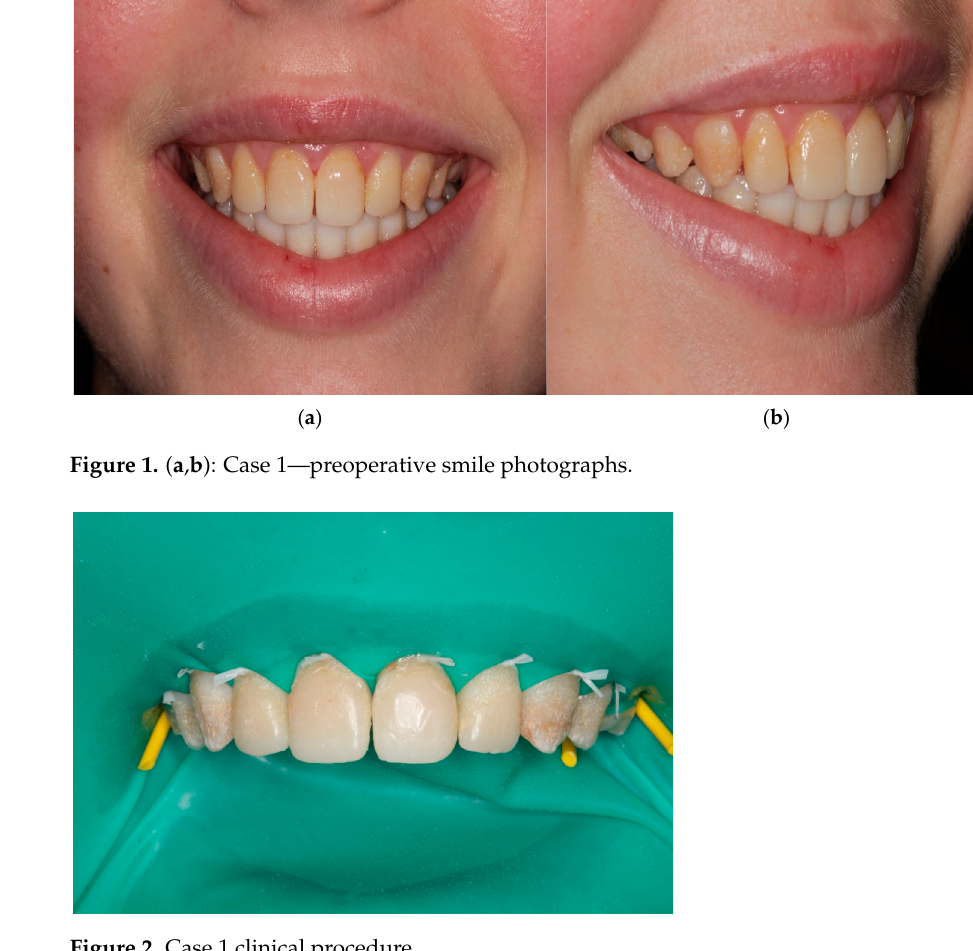
Figure 2. Case 1 clinical